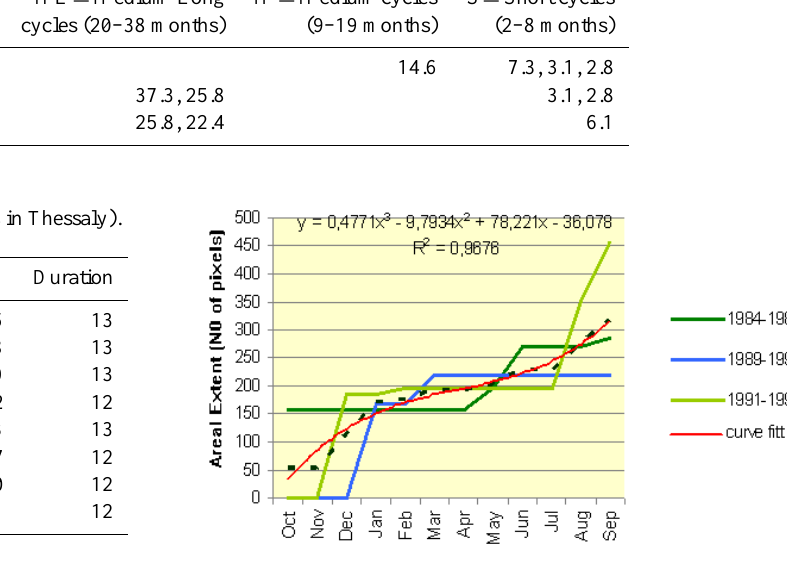
Fig. 4. Cumulative large areal extent (number of pixels 8X8 km 2 ) of extreme drought ( > 2.0) during drought years based on remotely sensed RDI. Figure 4. Cumulative Large Areal Extent (No of pixels 8X8 km 2 ) of extreme drought (>2.0) 28 during drought years based on remotely sensed RDI. 29 30